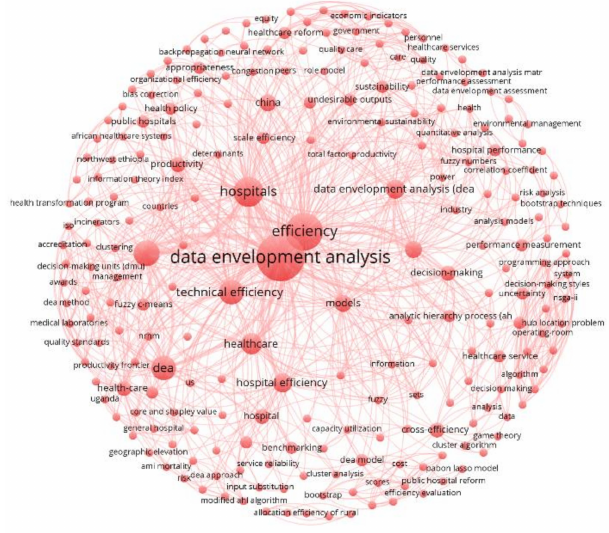
Figure 6. Keywords Co-occurrence for the Red Cluster.